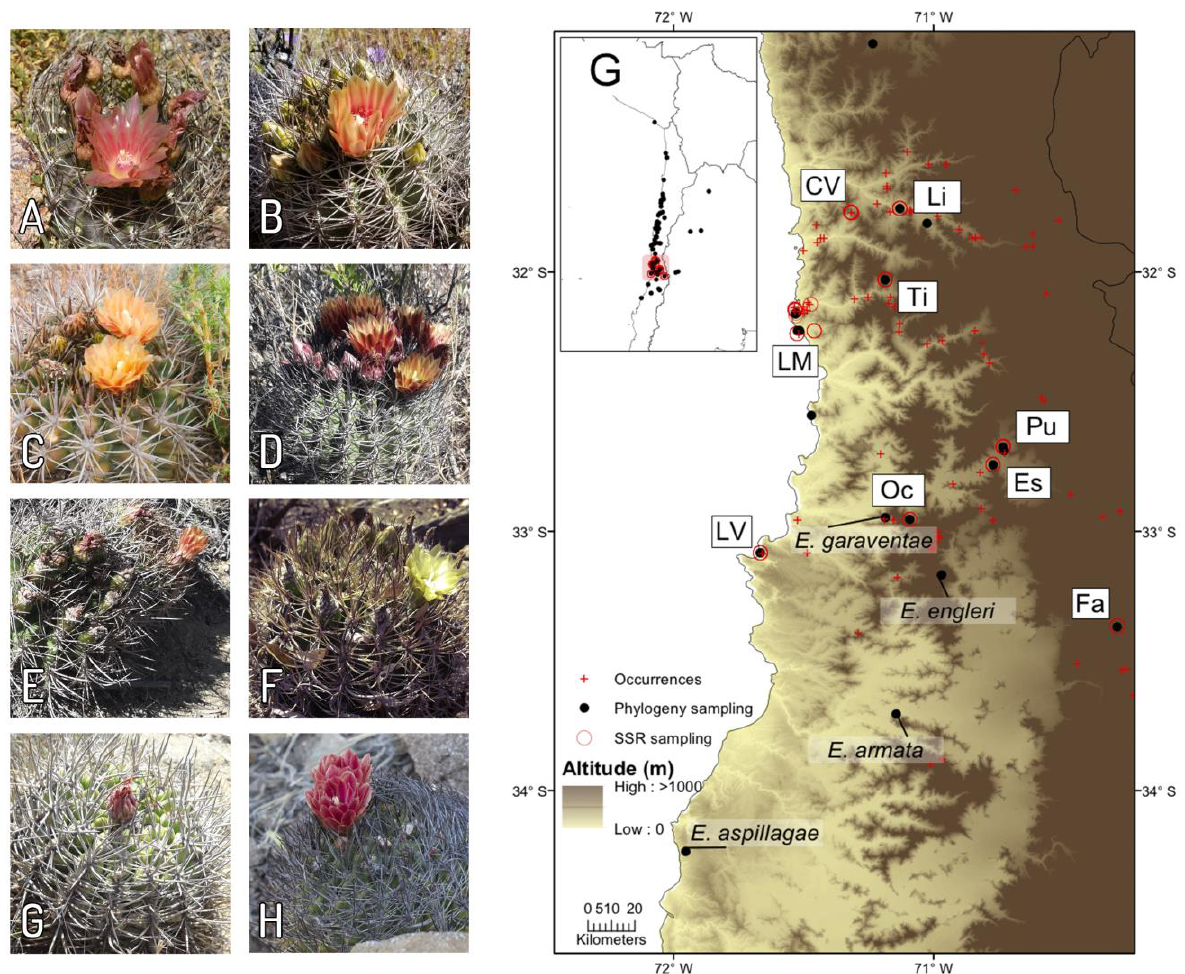
Figure 1. Morphological diversity of Eriosyce curvispina from nine populations sampled for phylo- genetic and population evolutionary inferences.: ( A ), Choapa Valley (CV); ( B ), Tilama (Ti); ( C ), Los Molles (LM); ( D ), Putaendo (Pu); ( E ), Ocoa (Oc); ( F ), Escorial (Es); ( G ), Laguna Verde (LV); ( H ), Farel- lones (Fa). Photos: A by M. Rosas; B and C by P.C. Guerrero; D and E by H.M.Villalobos-Barrantes; F and G by B. M. Meriño and H by J. Keymer. The map in G shows locations of E. curvispina populations in central Chile: red crosses are occurrences; the black dots are the sampling sites used in phylogenetic analysis; the empty circles are the sampling sites used in population